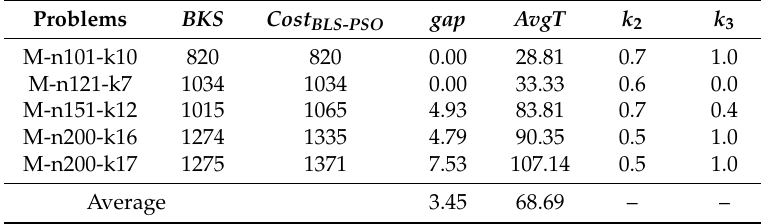
Table 8. Performance of BLS-PSO in solving the benchmark problems in Set